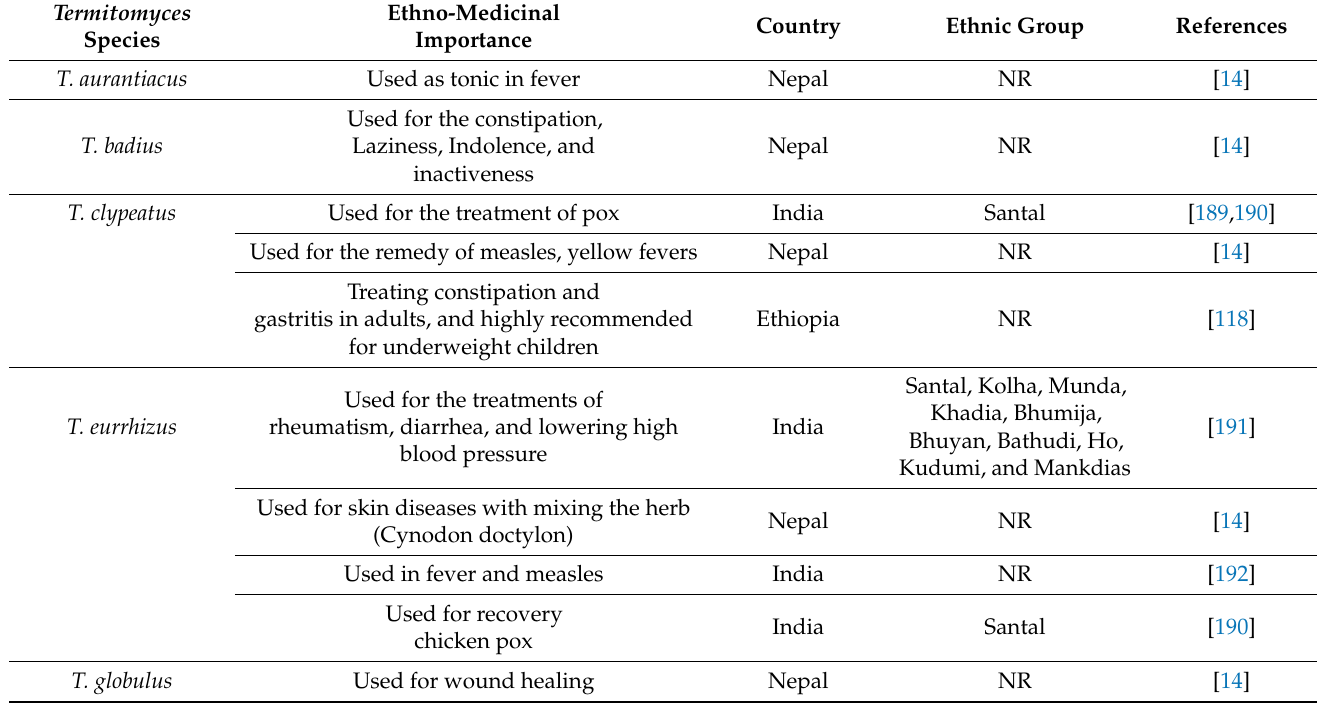
Table 2. Ethno-medicinal importance of different Termito.2yces